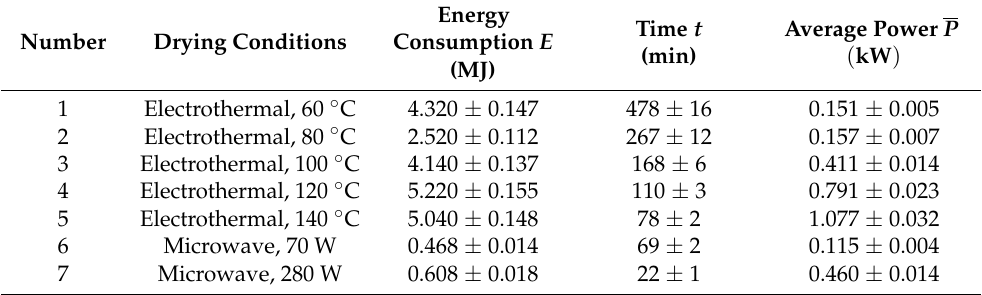
Table 4. Comparison of energy consumption between microwave drying and electrothermal